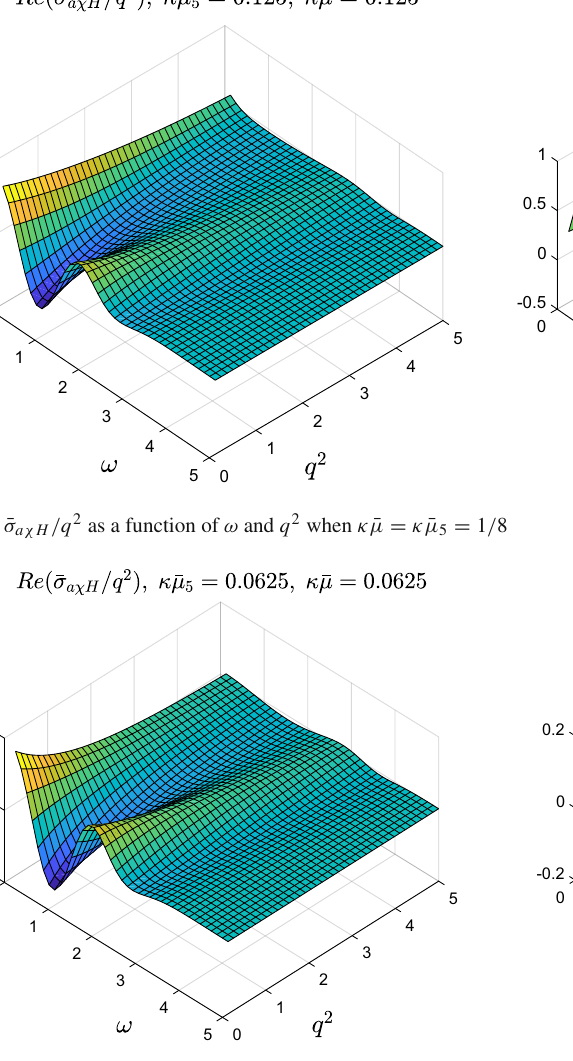
Fig. 11 TCF ¯ σ a χ H / q 2 as a function of ω and q 2 when κ ¯ μ = κ ¯ μ 5 = 1 /